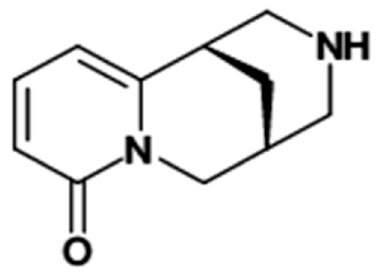
Figure 1. Cytisine Figure 1. Cytisine structure.